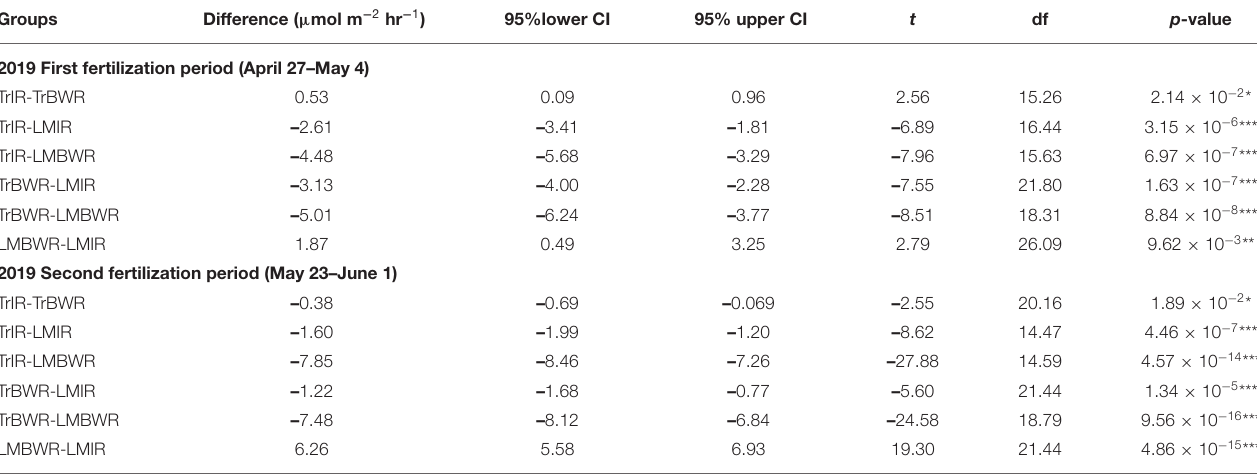
TABLE 7 | Mean CO 2 flux Welch t -test between certain two measurements among TrIR, TrBWR, LMIR, and LMBWR in in first ( n = 107) and second ( n = 93) fertilization periods in 2019.